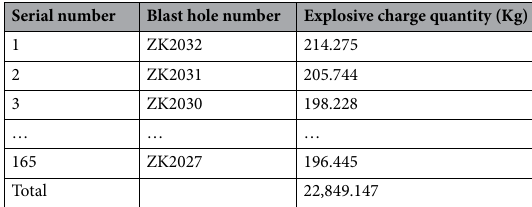
Table 6. Charge quantity of blasting 3D model calculation.